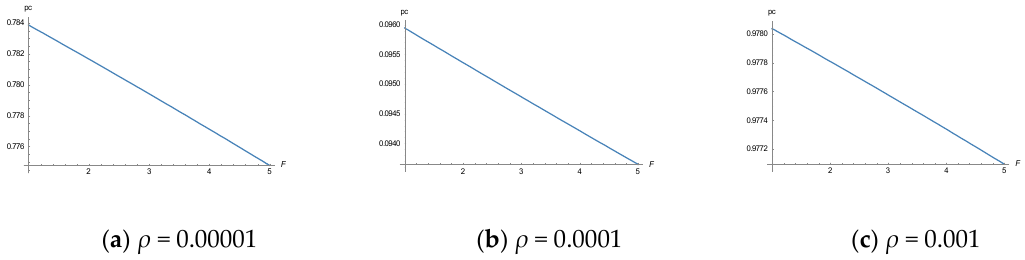
Figure 5. Tax compliance probability, p c , as a function of F for different values of ρ : ( a ) ρ = 0.00001, ( b ) ρ = 0.0001 and ( c ) ρ = 0.001 .